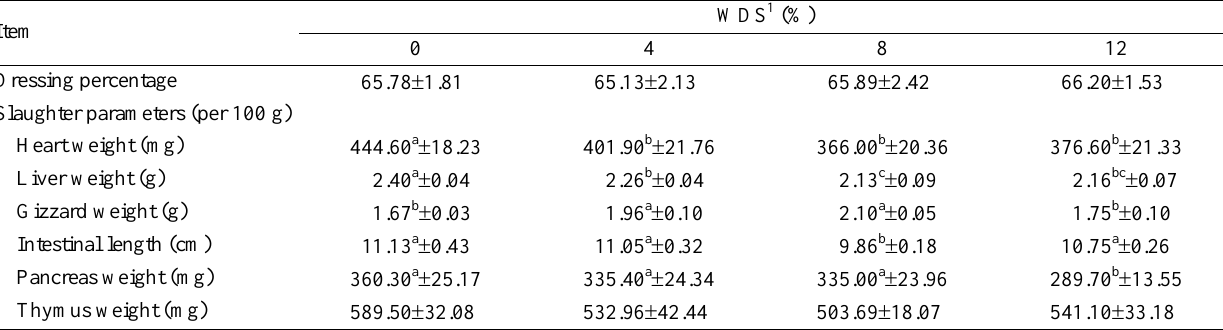
1 0, 4, 8 and 12 WDS indicates percent inclusion of washed distillery sludge in the diets. Means in a row with different superscripts differ significantly